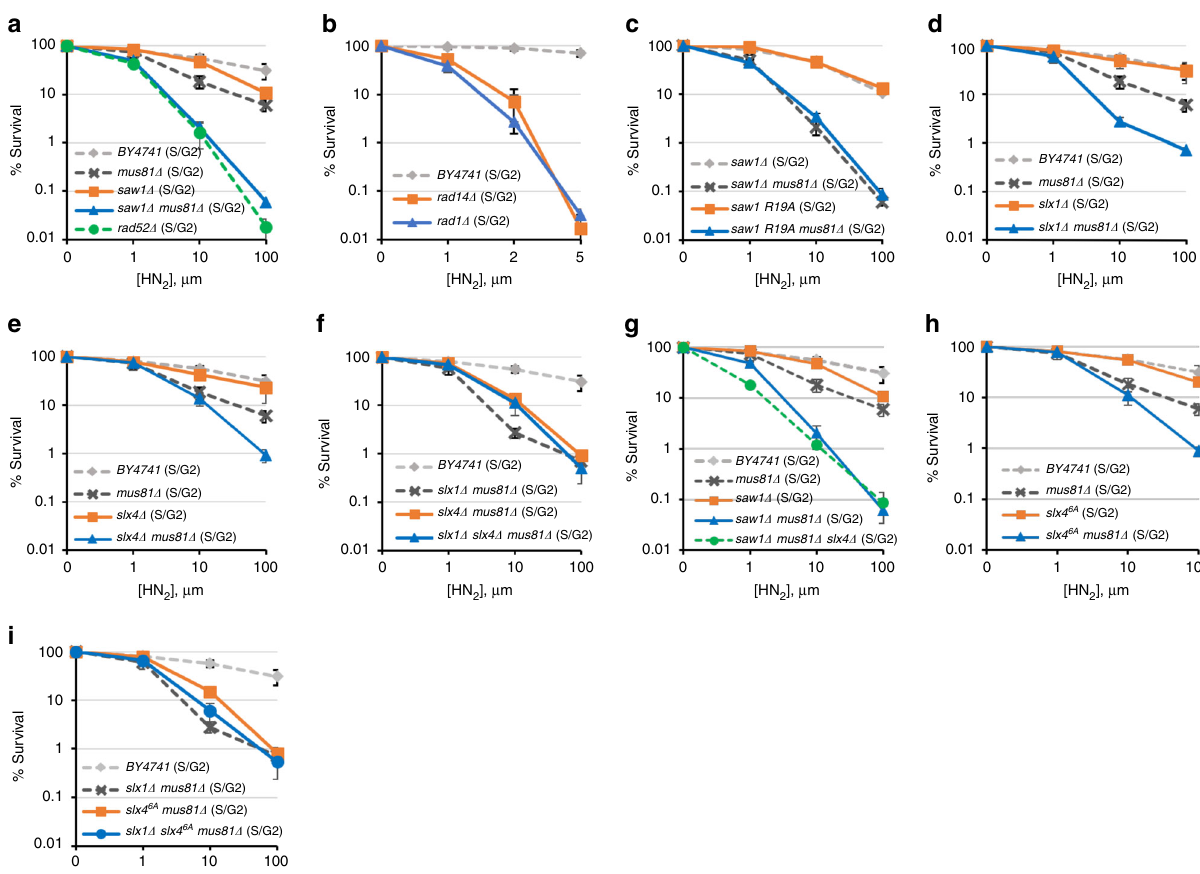
Fig. 1 ICLR in S/G2 phase. a – i Yeast cells with indicated gene deletions were synchronized in G1 by α -factor treatment and then released into medium with different concentrations of HN 2 for 2 h before plating. The results of three independent experiments + s.d. are shown. Please note that the range of the x - axis in panel b is much smaller than all other panels, due to the extreme sensitivity of these mutants to HN 2